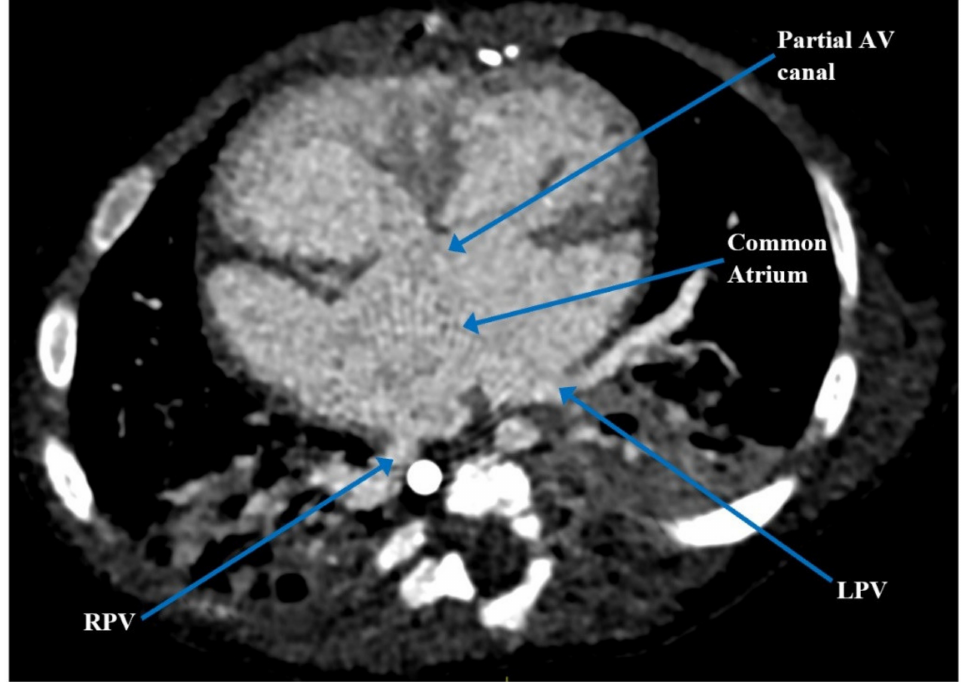
Figure 1. Pre-operative computerized tomography demonstrating atrial situs ambiguous with a common atrium, partial AV canal and ipsilateral pulmonary venous drainage. AV = atrioventricular; LPV = left pulmonary vein; RPV = right pulmonary